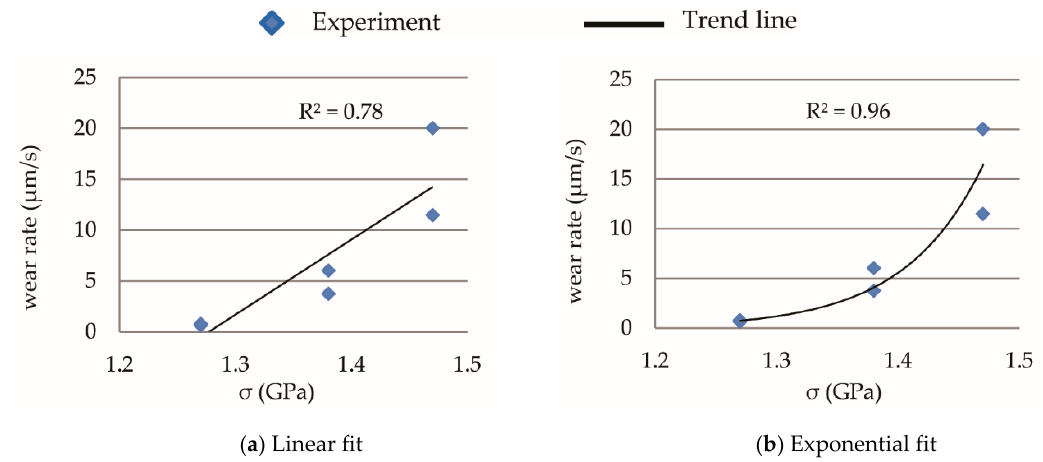
Figure 12. Relation between the experimental wear rate in the initial cutting period and the simulated Von Mises stresses.